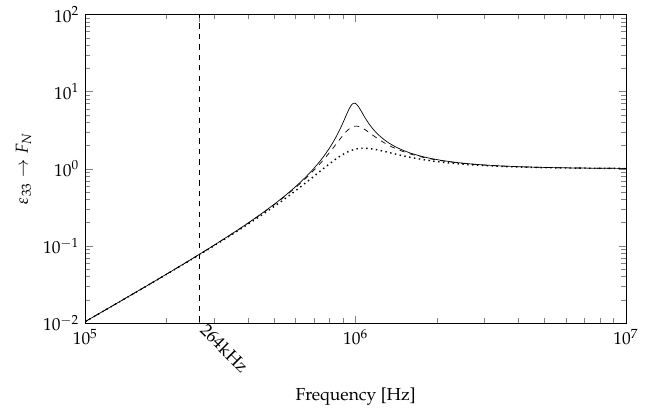
Figure 8. Simulated cross spectrum for the correlation of piezo-strain and normal force on the plate with different Lehr’s damping measures: solid 0.050; dashed 0.10; dotted 0.20. Scaled to F N ( ω ∞ ) . is caused by the spring-mass-damper behaviour of the actuator mounting. The resonance of the actuator-epoxy system creates a higher excitation force, amplifying other system resonance frequencies. This behaviour could be used to gain higher amplitudes in the resonance regions by manipulating the epoxy thickness or by adding mass to the actuator during application. This article focuses on the first resonance frequency at 264 kHz. Figure 9 shows the absolute amplitude of the cross power spectra at 264 kHz for all given measurement points of one direction on surface of the steel plate. A concentric distribution of the amplitudes is clearly visible which indicates the desired infinite plate